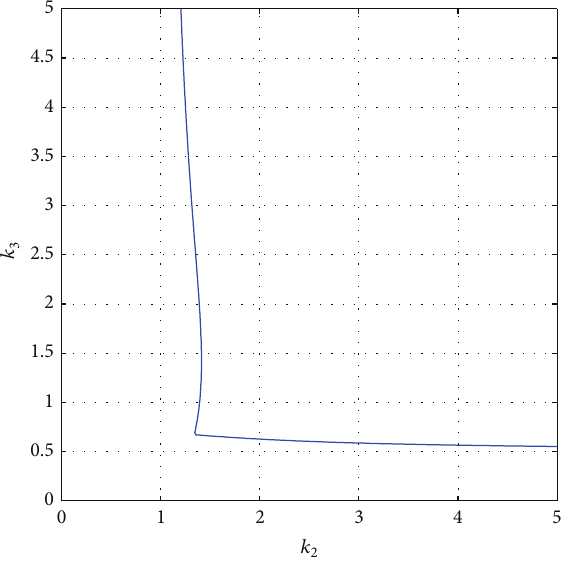
Figure 2: Gain region boundary 𝜕 K 𝑟 .